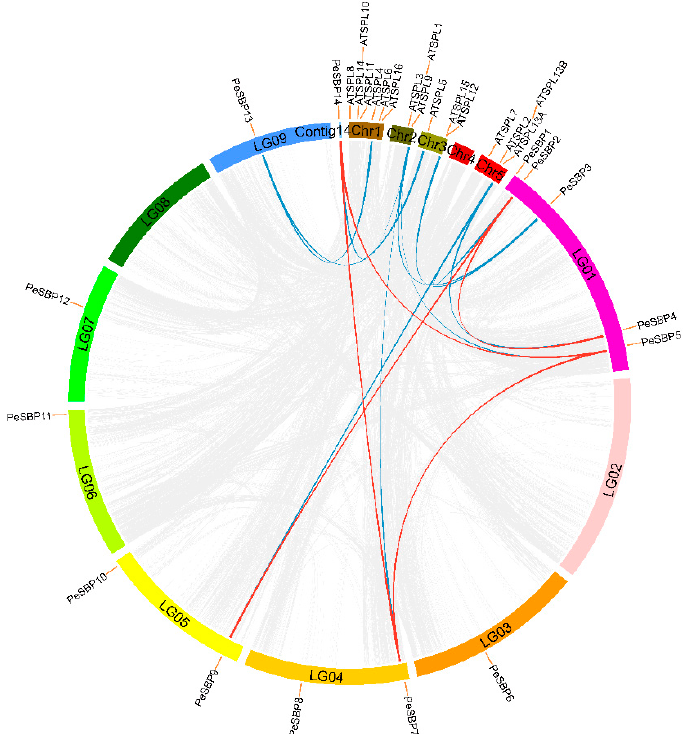
Figure 6. Synteny analysis of the SBP genes from passion fruit and Arabidopsis . The red lines indicate SBP gene pairs within passion fruit, and the blue lines indicate SBP gene pairs between passion fruit and Arabidopsis . Chr indicates the chromosome of Arabidopsis , and LG and contig indicate the chromosome of passion fruit.